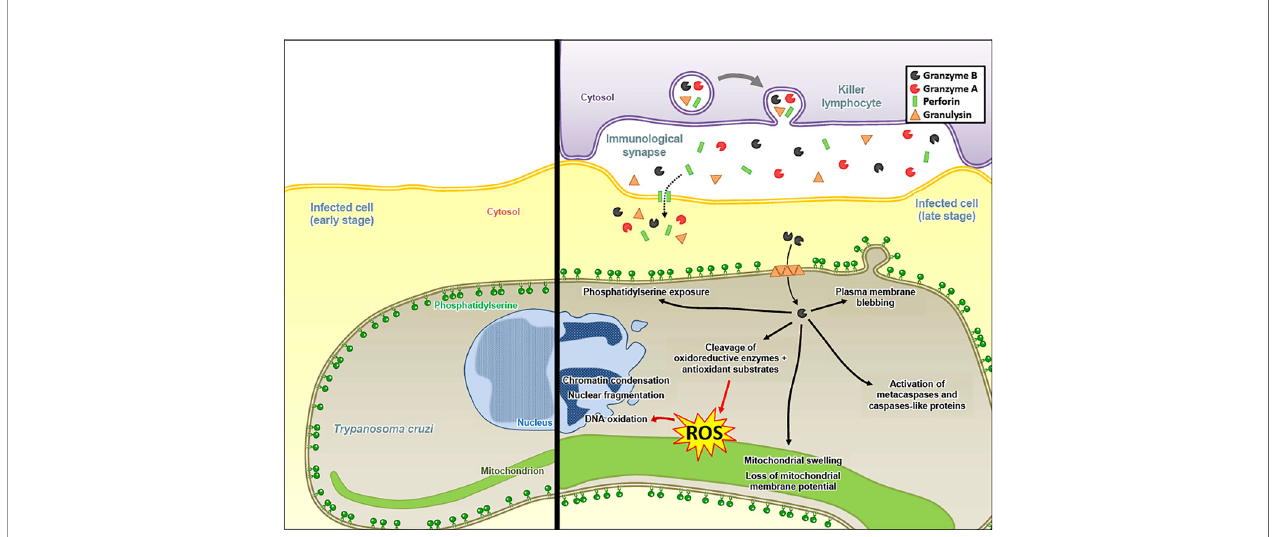
FIGURE 4 | Granzyme B induces an apoptosis-like death pathway in Trypanosoma cruzi . The Gzms of killer lymphocyte granules reach the cytosol of T. cruzi in an infected host cell via a PFN- and GNLY-dependent delivery mechanism. After entry into the parasites, GzmB targets antioxidant defense substrates, which leads to the accumulation of ROS, responsible for DNA oxidation. GzmB triggers classical mammalian apoptosis features: (1) chromatin condensation and nuclear fragmentation, (2) mitochondrial swelling and loss of membrane potential, (3) plasma membrane blebbing, and (4) phosphatidylserine exposure. GzmB also induces the activation of metacaspases and caspase-like proteins, although it might not be required for GzmB-mediated parasite